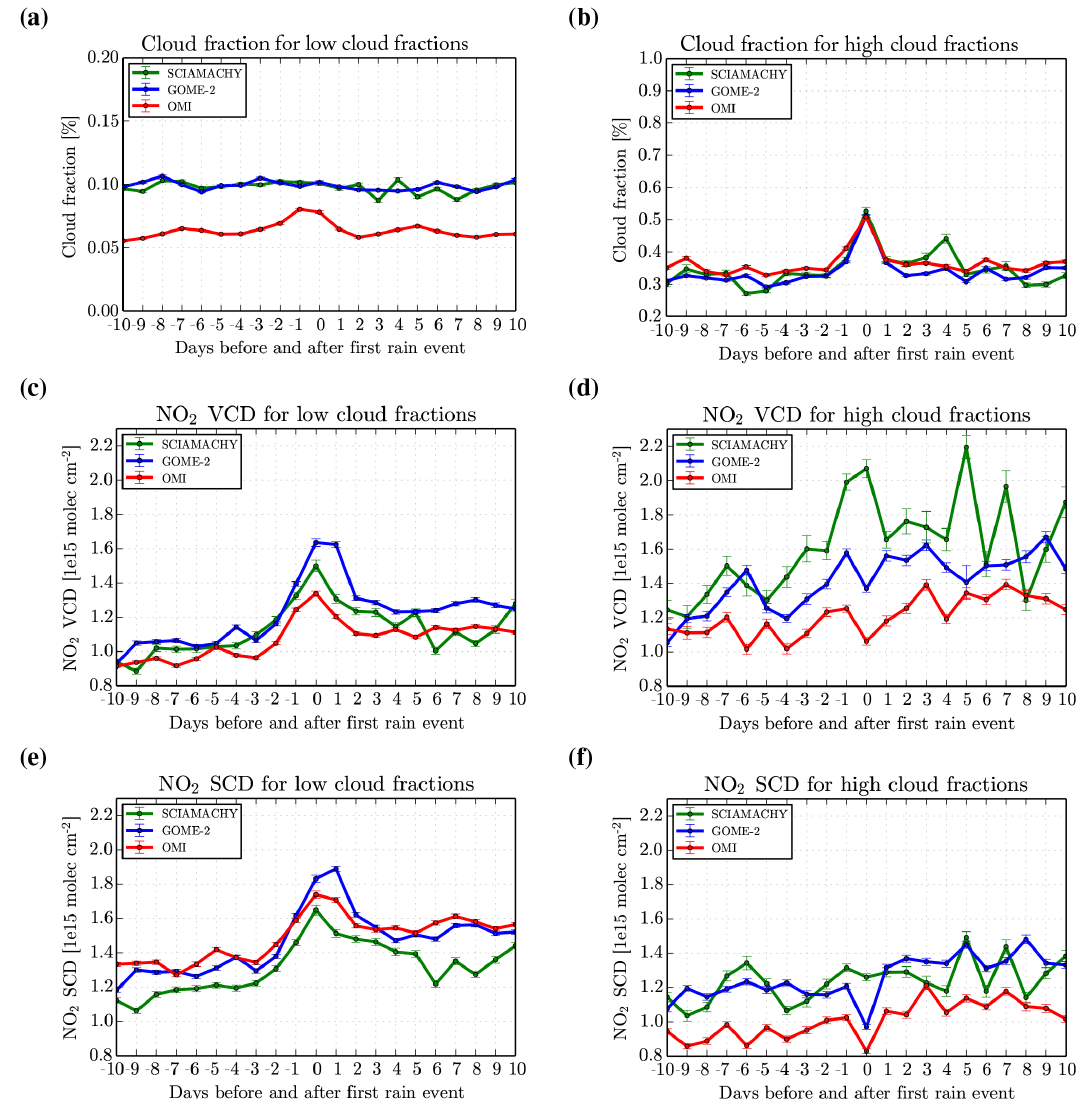
Figure 9. Investigation of cloud effects on the retrieved NO 2 SCDs and VCDs. (a) Mean cloud fraction of the three satellite instruments for the reference case (cloud fraction < 20%). (b) Mean cloud fraction of the three satellite instruments but considering only observa- tions with cloud fraction > 20%. (c) NO 2 VCDs for the reference case. (d) NO 2 VCDs only considering observations with high cloud cover (cloud fraction > 20%). (e) NO 2 SCDs for the reference case. (f) NO 2 SCDs only considering observations with high cloud cover (cloud fraction >